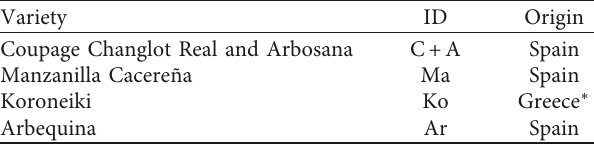
Table 1: Identification of extra virgin olive oil samples analyzed.